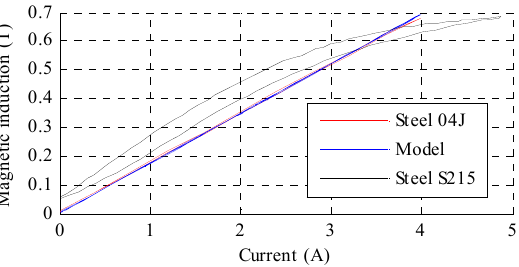
Figure 7. Magnetic induction measured in air gap vs. current for low-carbon steel 04J, steel S215, and model which represents equivalent circuit.